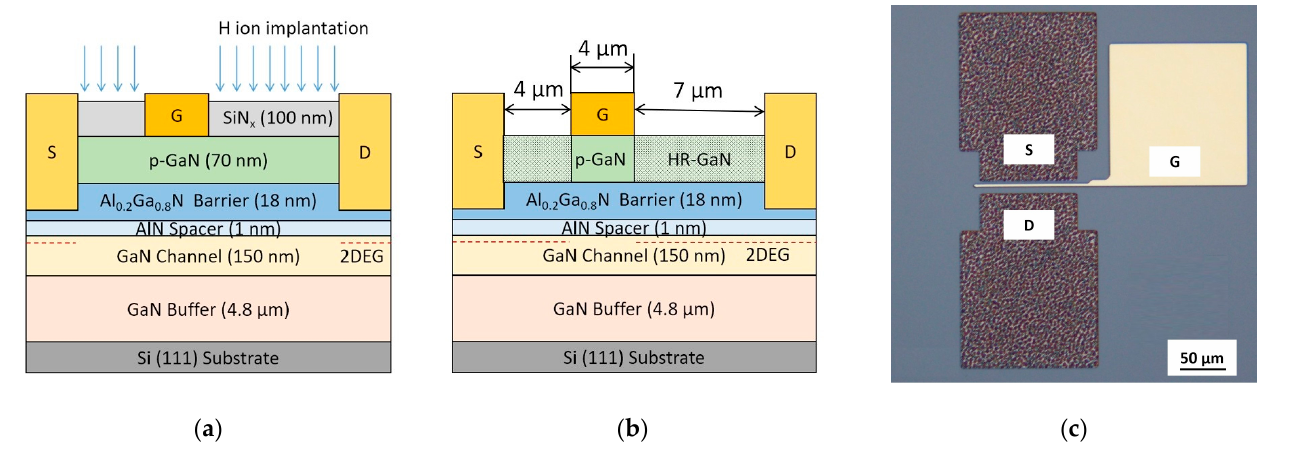
Figure 1. Schematic diagram of p-GaN HEMTs: ( a ) H ion implantation; ( b ) p-GaN selective passivation; ( c ) optical image of the p-GaN HEMT.